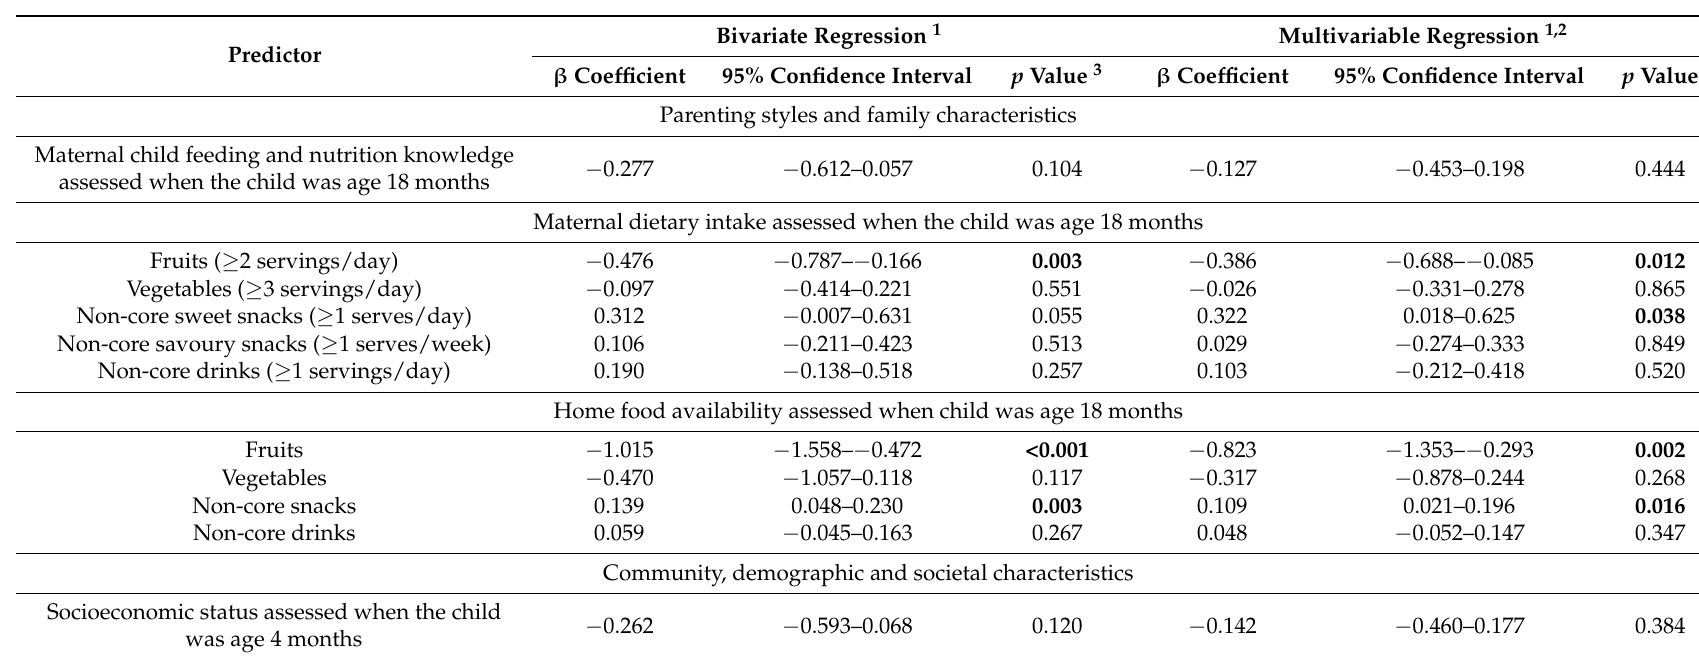
Table 3. Results of bivariate and multivariable linear regression analyses among children participating in the Melbourne InFANT Program ( n = 209) for the predictors and the dietary energy density variable dietary energy density from food (DED food